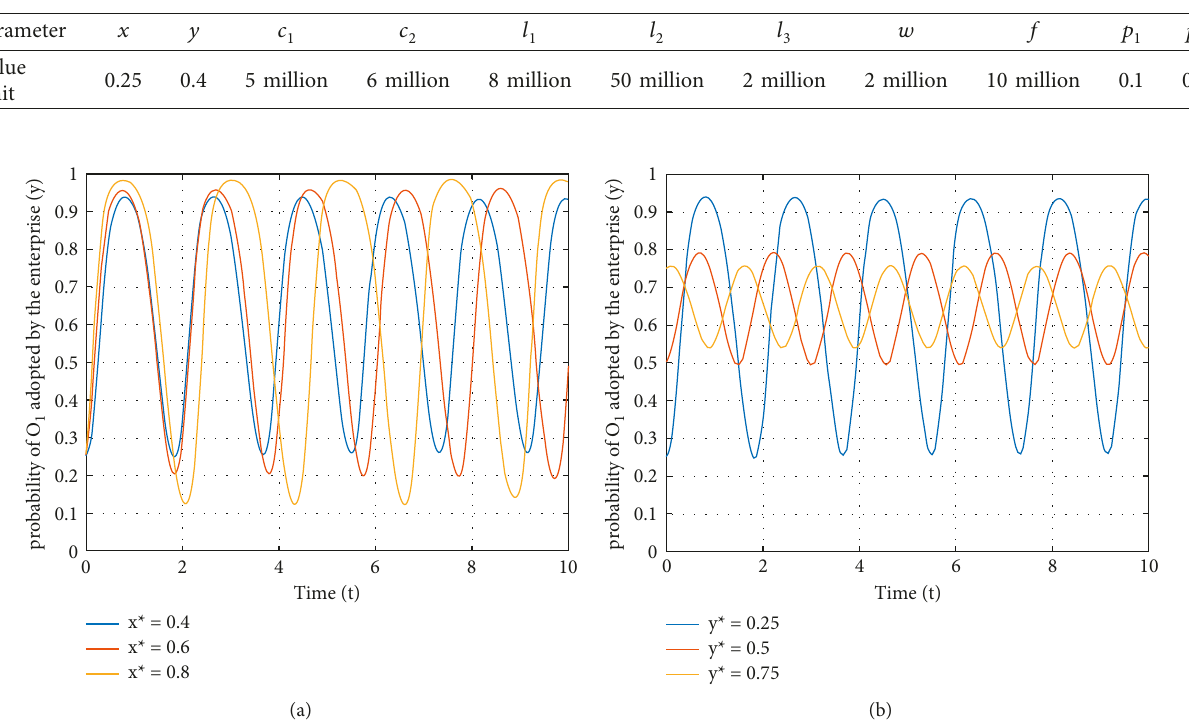
Figure 4: Evolutionary stabilization paths of local government and enterprise in system 1 for different initial values.